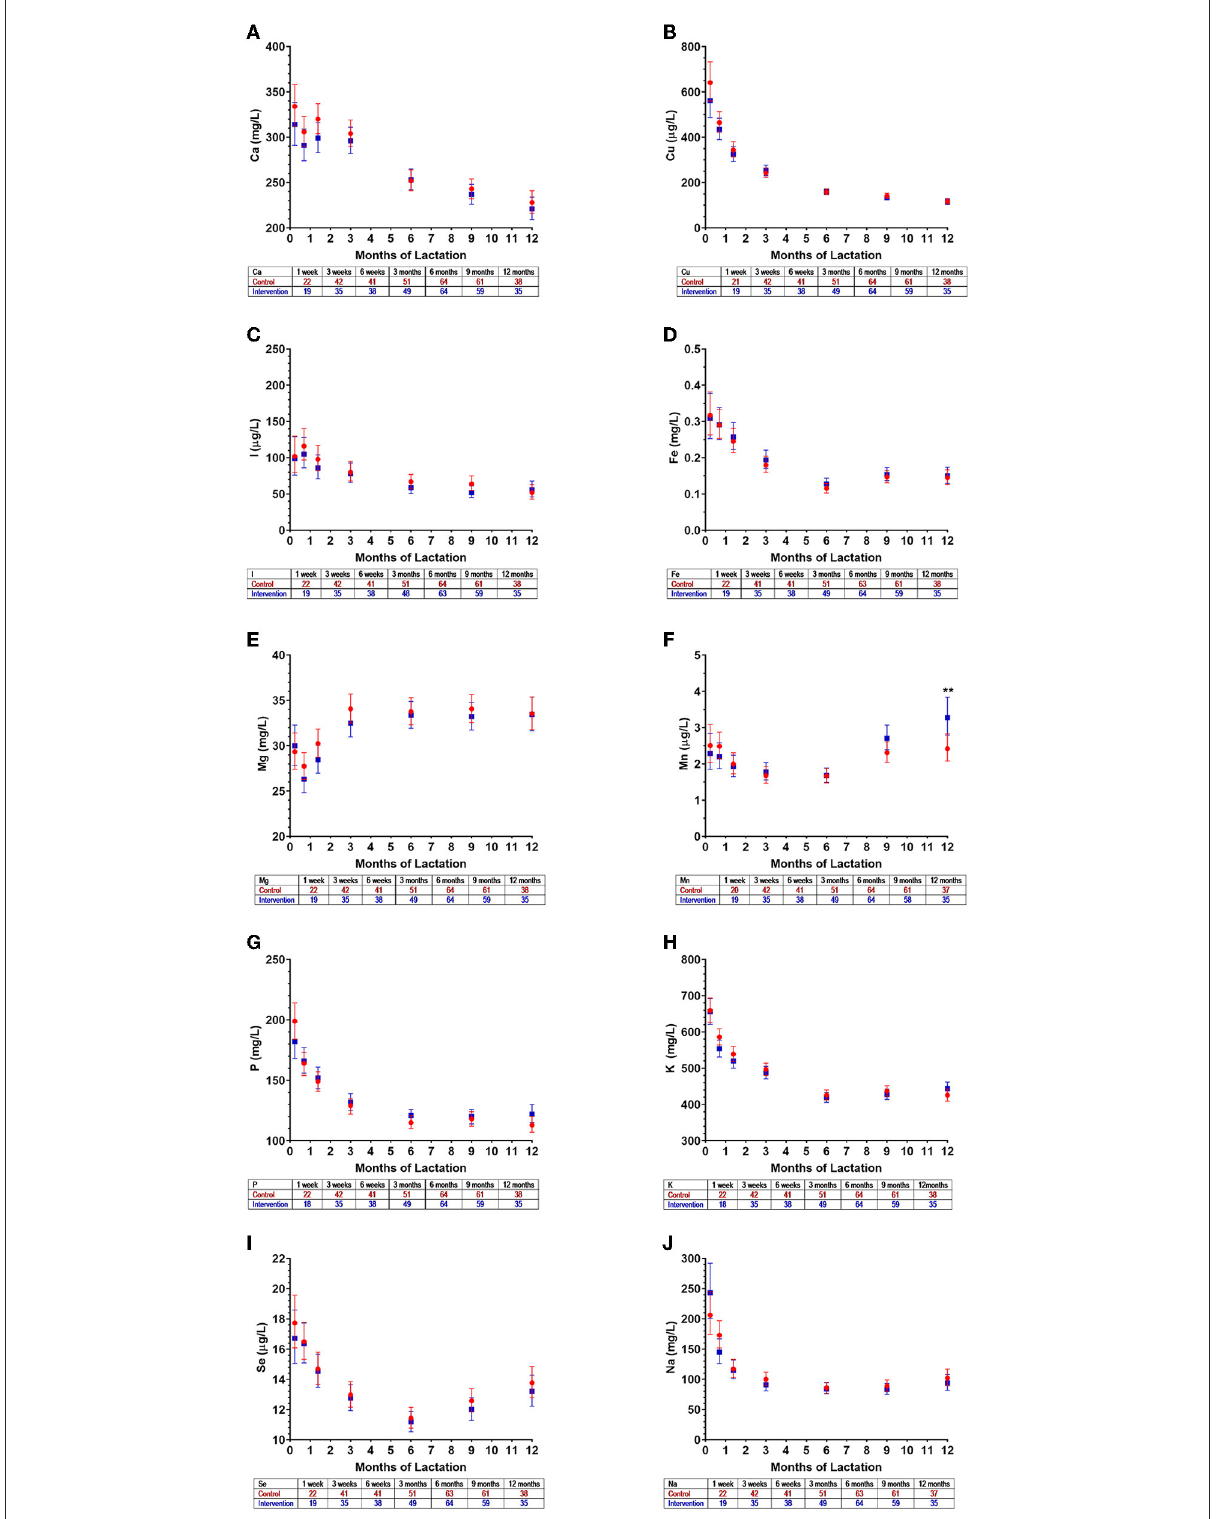
FIGURE5 Mineral concentrations in human milk from control ( ) and intervention ( ) groups in New Zealand in the NiPPeR study during 12 months of lactation: (A) calcium, (B) copper, (C) iodine, (D) iron, (E) magnesium, (F) manganese, (G) phosphorus, (H) potassium, (I) selenium, and (J) sodium. Data are the least-squares means (i.e., adjusted means) for each group adjusted for visit, a group*visit interaction term, adherence, maternal pre-pregnancy body mass index, and gestational age at birth; error bars represent the respective 95% confidence intervals. ** p < 0.01 for the difference between intervention and control at a given time point. The number of HM samples per group analyzed at a given time point are provided in the tables below the x